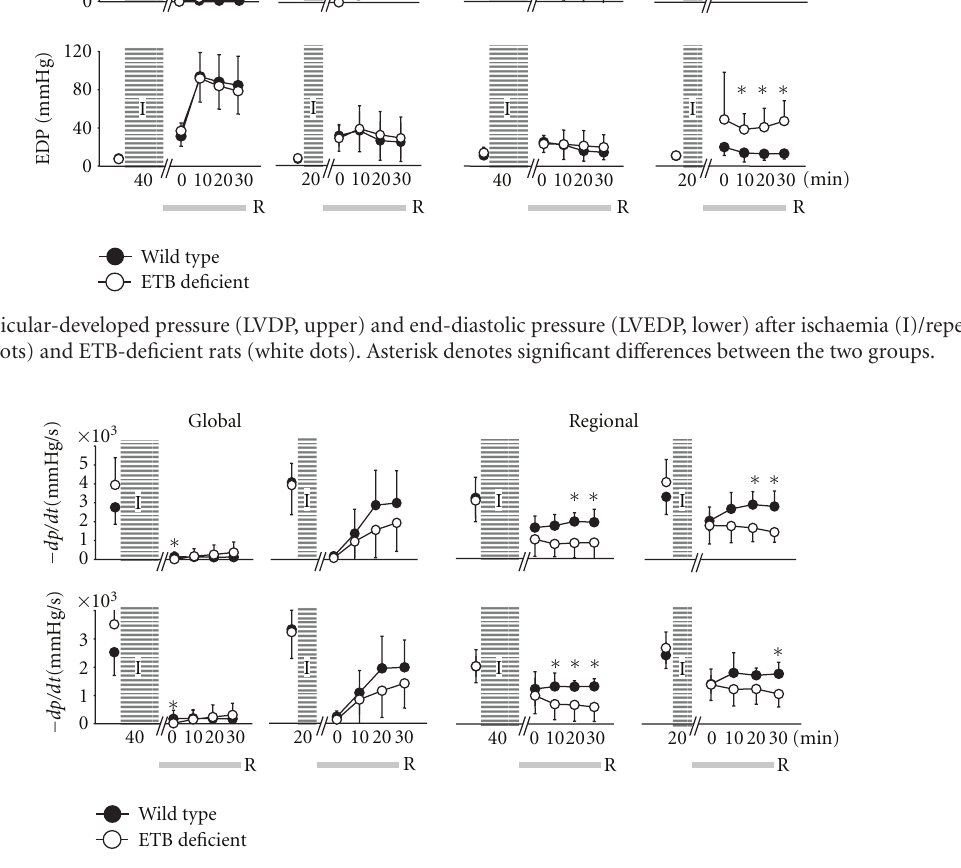
Figure 2: Maximum values (maximum + dp/dt , upper) and minimum values (maximum − dp/dt , lower) of the first derivative of left ventricular pressure after ischaemia (I)/reperfusion (R) in wild-type (dark dots) and ETB-deficient rats (white dots). Asterisk denotes significant di ff erences between the two